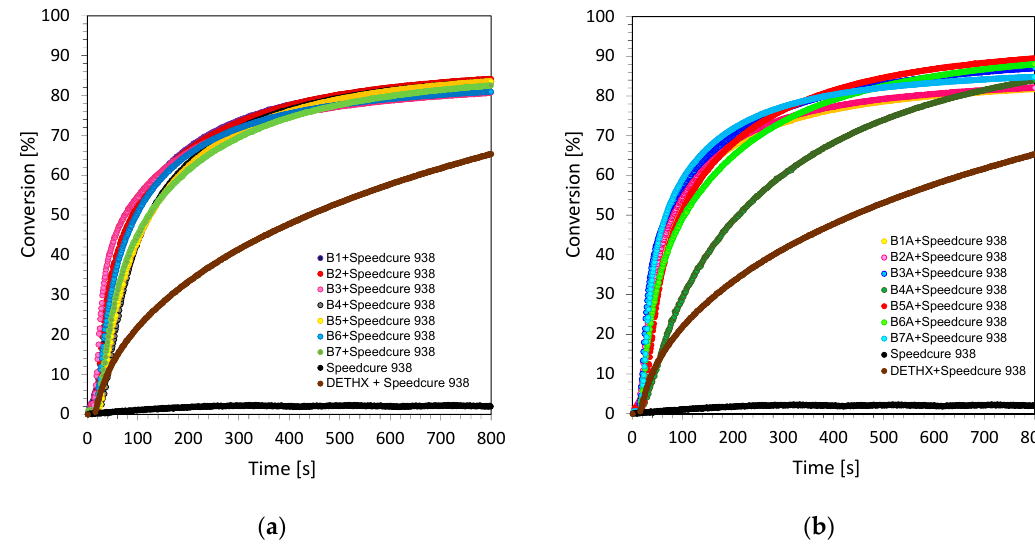
Figure 4. Cationic photopolymerization profiles DEGDBA/EPXPROP (70/30% w/w) (glycidyl group function conversion vs. irradiation time) initiated by bimolecular photoinitiating system based on Speedcure 938 (2% wt.) and biphenyl derivatives (0.2% wt.) under light irradiation at 365 nm for ( a ) biphenyl derivatives from series 1, ( b ) biphenyl derivatives from series 2.